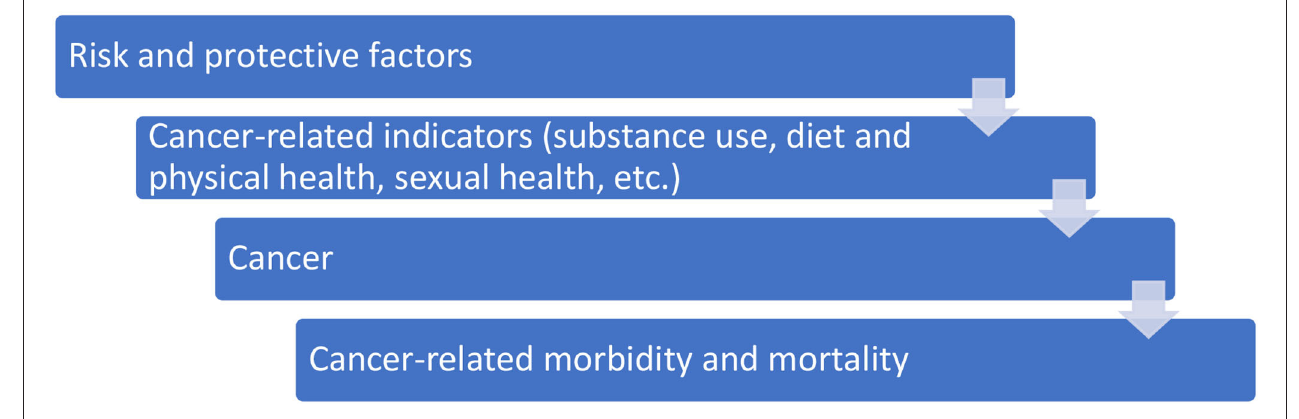
FIGURE 1 | Concept model for cancer related risk and protective